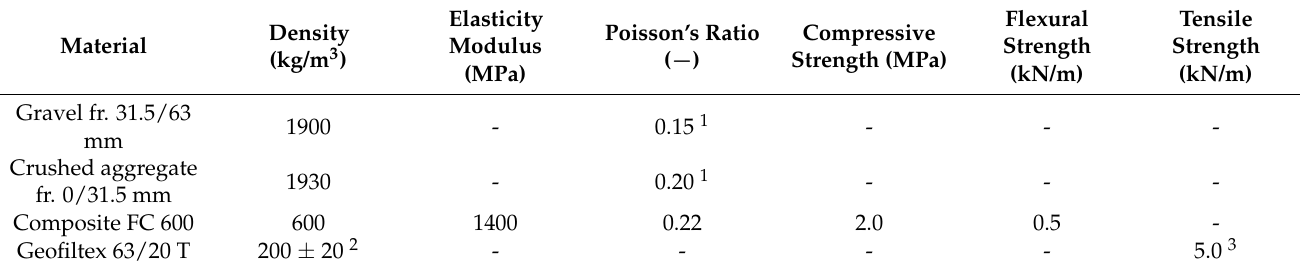
Table 1. Strength and physical parameters of used